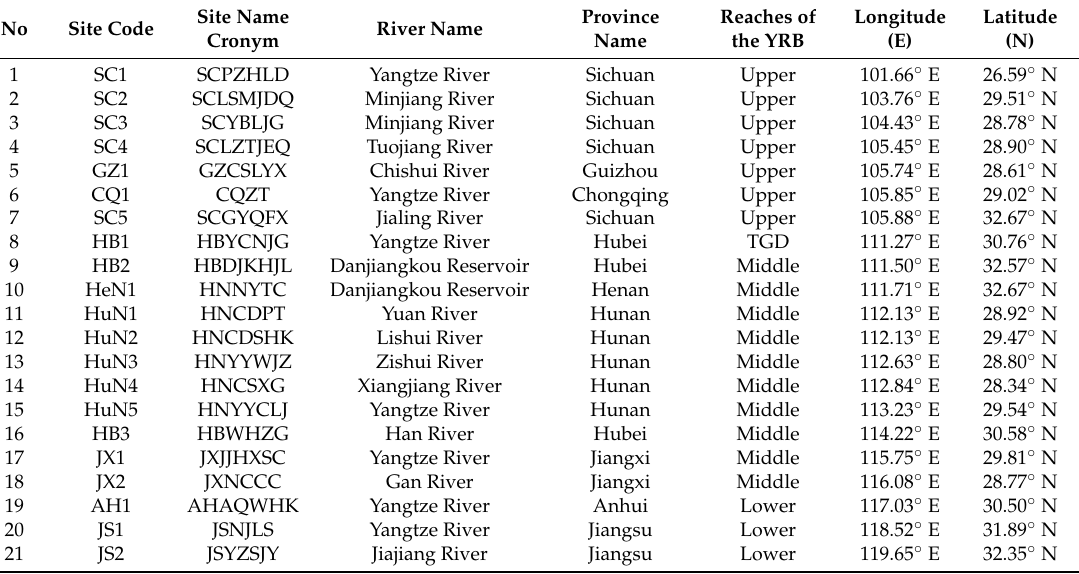
Table 1. Basic information of sites in the YRB (from west to